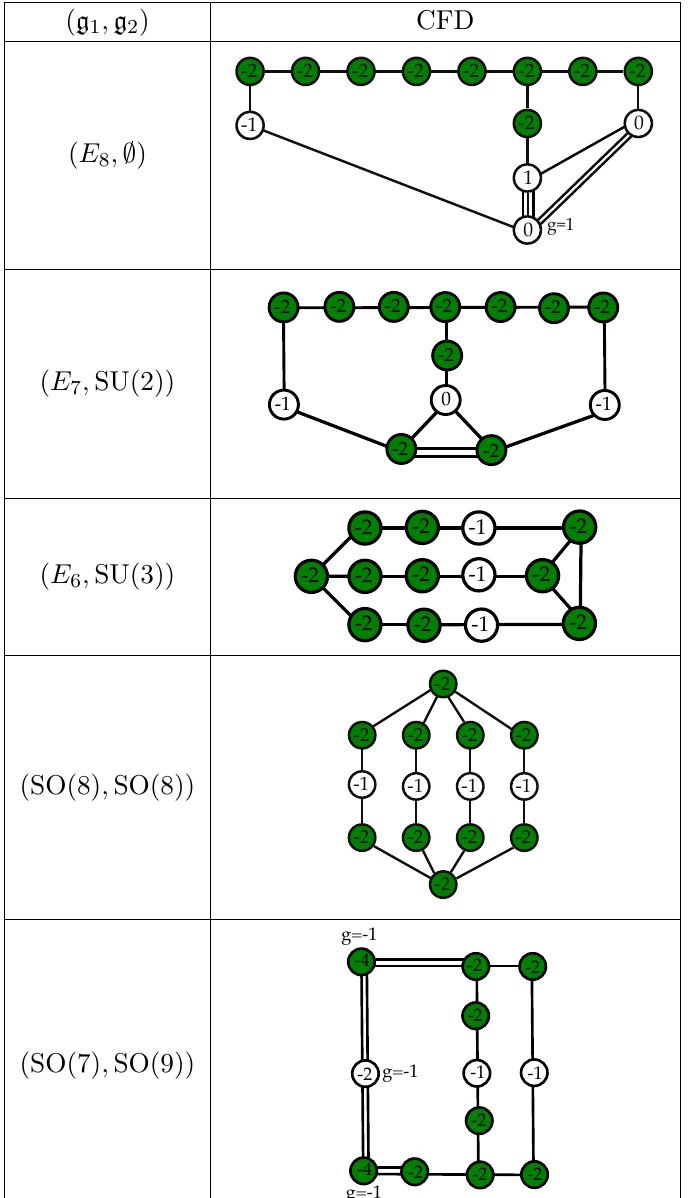
Table 8. CFDs for the marginal rank 1 E-string obtained by di(cid:11)erent collisions of G 1 and G 2 singularities. The maximal manifest (cid:13)avor symmetry is realized only in the ( E 8 ; ; ) model. For all other the manifest (cid:13)avor symmetry is b G 1 (cid:2) b G 2 , and enhances to ^ E 8 by including the additional BPS states. However these di(cid:11)erent realizations are useful for the gluing process.